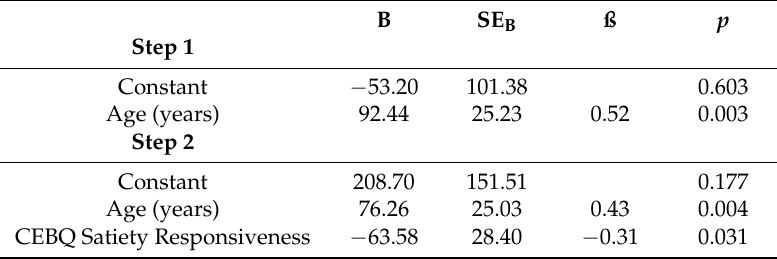
Table 5. 100% total meal energy intake regression model.